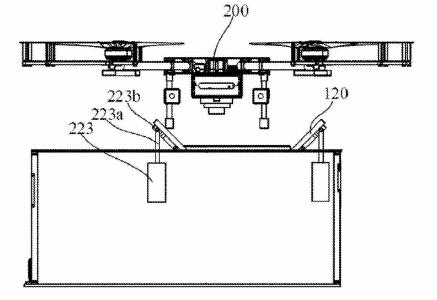
Figure 32. Positioning mechanism and unmanned aerial vehicle [83] by Shenzhen DJI Innovation Technology Co., Ltd. 120, rails (slope); 200,